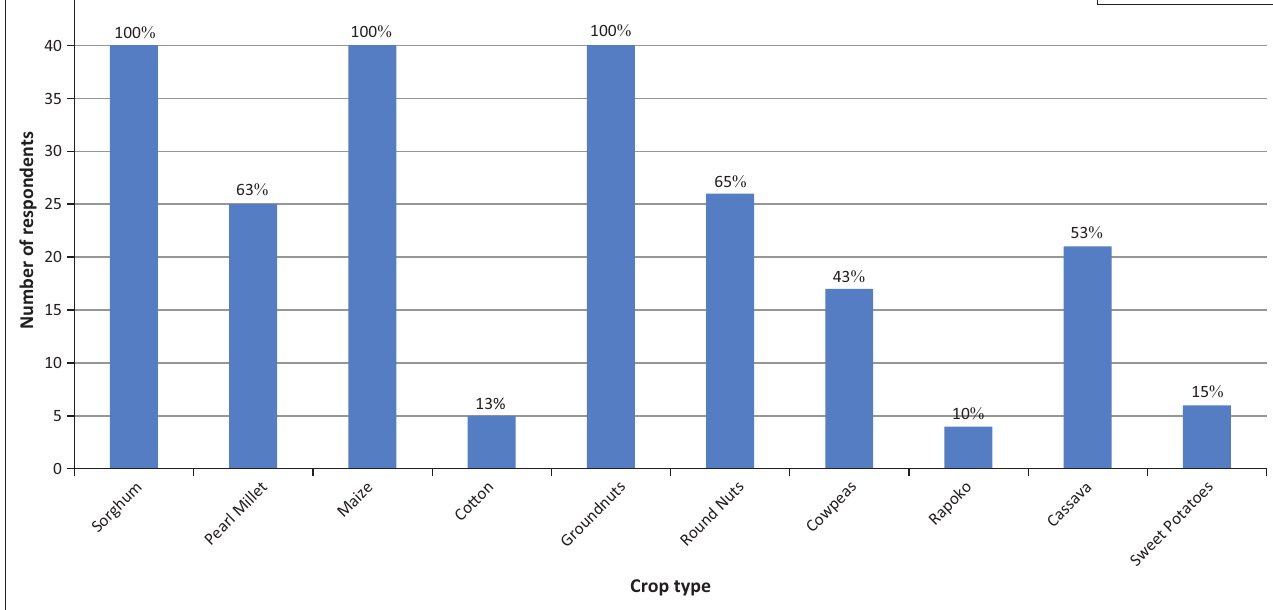
FIGURE 7: Crops that are grown in Chilonga Ward.